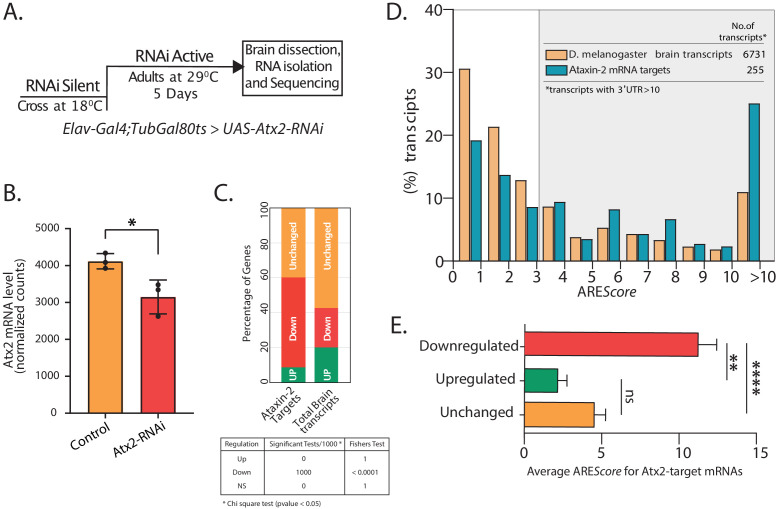
Atx2–ARE interactions modulate mRNA stability.(A) Schematic of strategy to induce RNAi expression specifically in adult fly brain. Total RNA extracted from brain post 5 days at 29°C was sequenced using Illumina 2500 and differential expression analyzed using DESeq2. (B) Normalized mRNA read counts showing Atx2 mRNA levels to be significantly reduced following RNAi expression compared to Gal4 control with a p-value of <0.0298 using Student’s t-test. (C) Effect on Atx2-target mRNAs following Atx2 knockdown: the majority are reduced in level, indicating a role for Atx2 is target stabilization. Bootstraping was performed 1000 times with replacement. Statistics was performed using chi-square test with cutoff (p-value <0.05). Fisher’s test was used to combine the p-values. (D) AREScore analysis showing AU-rich elements (AREs) to be enriched in Atx2-target mRNAs compared to the brain transcriptome. (E) Among Atx2-target mRNAs, higher ARE scores are seen in mRNAs whose levels are reduced following Atx2 knockdown.
Figure 3—source data 1.Data related to Figure 3C.Fold changes in Atx2-target mRNAs upon Atx2 RNAi.

Figure 3—source data 2.Data related to Figure 3E.Correlation of AREScore and target mRNA levels.